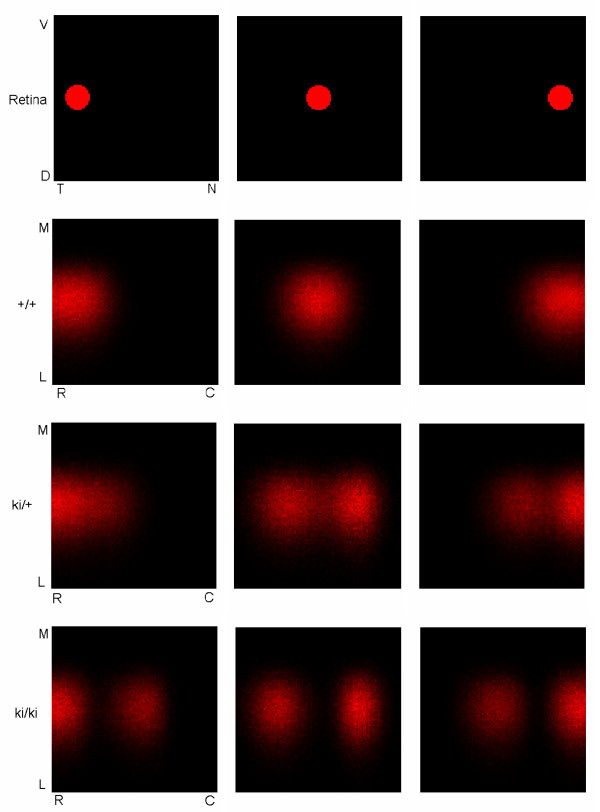
Numerical simulation of labelling in the 2D model. The top row shows anterograde "labeling spots" in retina. The following three rows display corresponding distribution of label in SC. The size of both retinal and collicular arrays is 100 by 100 cells. The three rows show results for wild-type, heterozygous knock-ins, and homozygous knock-ins, as marked on the left. Notice the doubling transition, when going from temporal to nasal injection in heterozygotes. This Figure is to be compared to Figure 4 from Ref. [20]. α = β = 30. The color map is shifted in each image for visibility. Abbreviations: D, dorsal; V, ventral; N, nasal; T, temporal; C, caudal; R, rostral; L, lateral; M, medial.